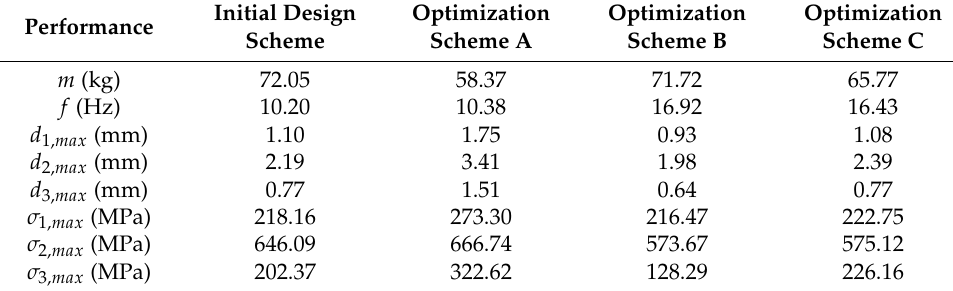
Table 6. Performance comparison of optimization